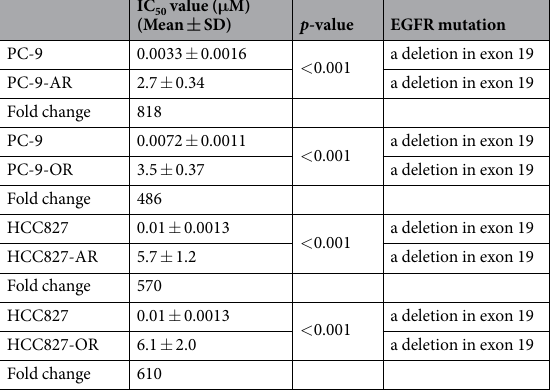
Table 1. IC 50 values and T790M/C797S status in EGFR-TKIs-resistant cell